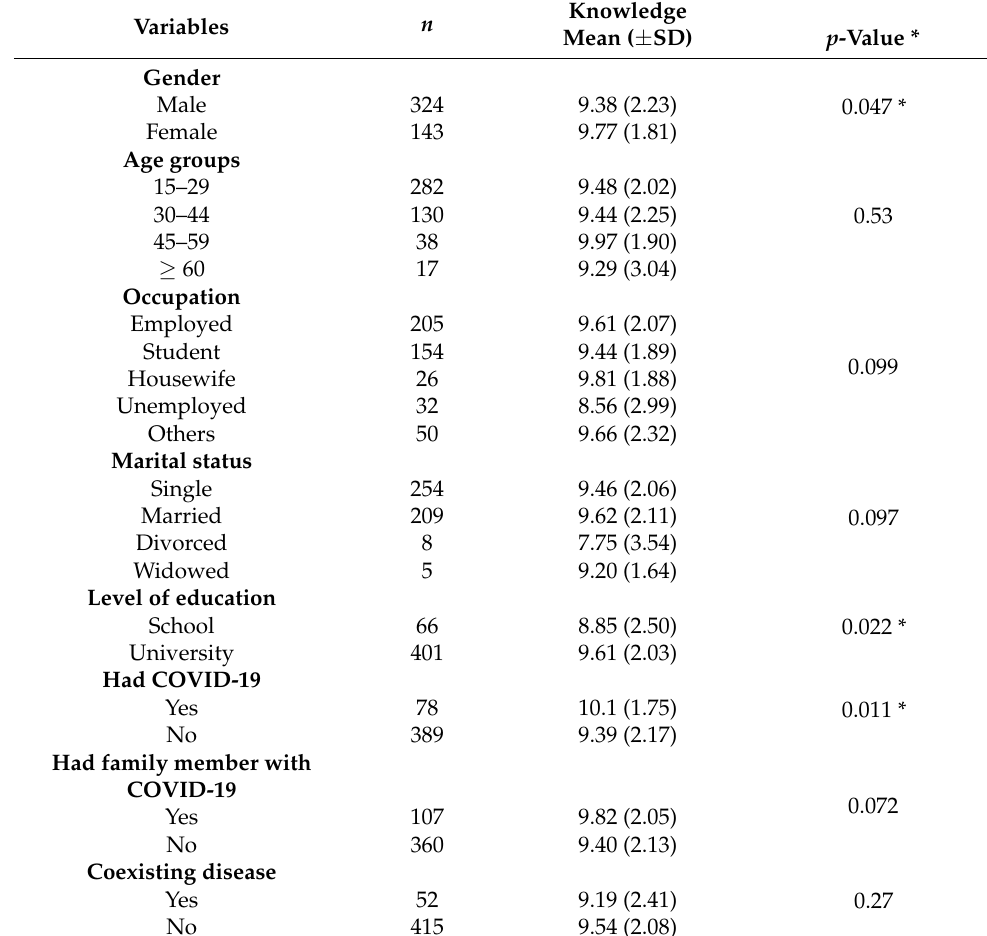
Table 3. The difference in means of knowledge score among study participants ( n =